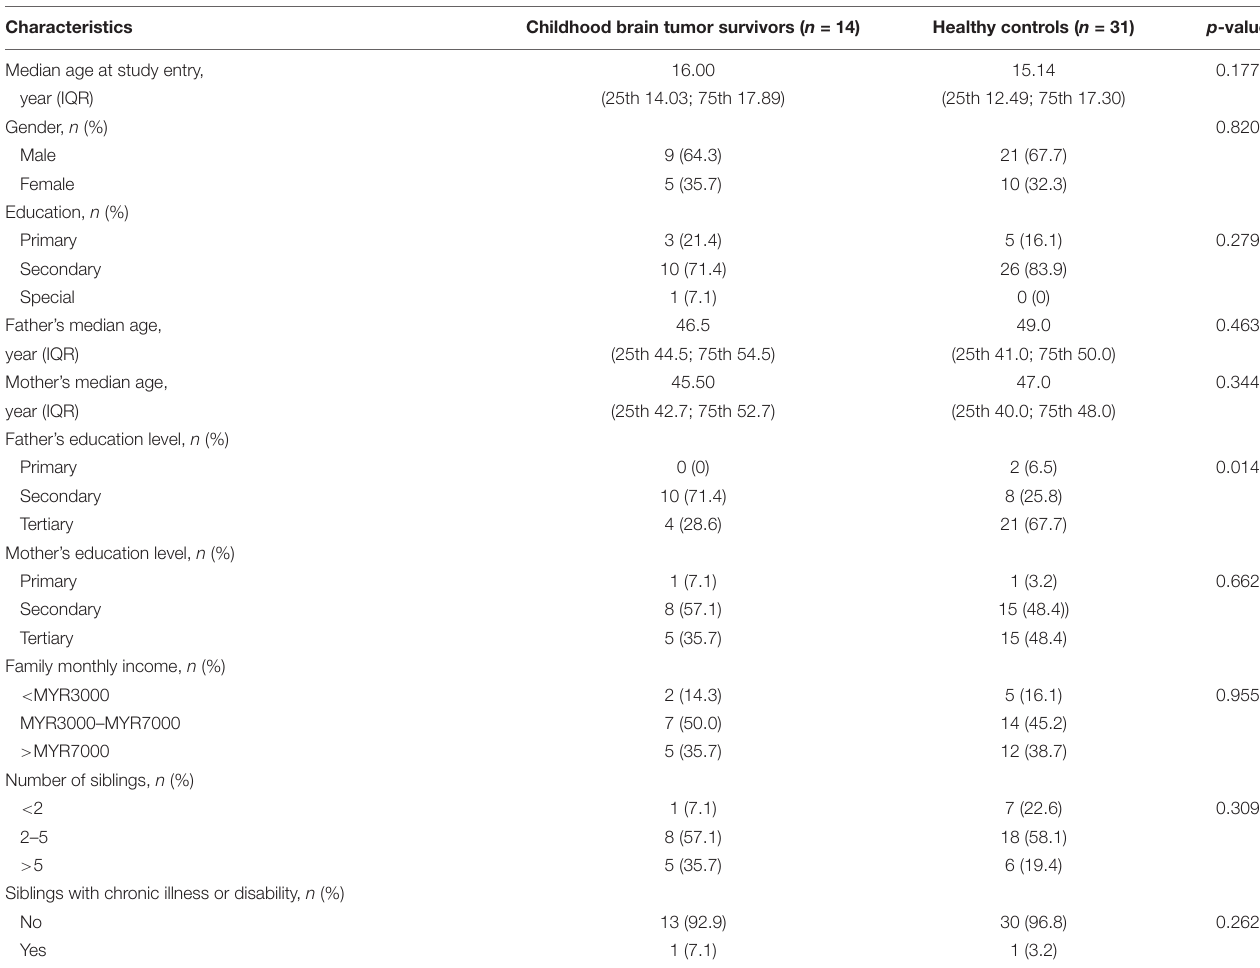
TABLE 1 | Demographic characteristics of study